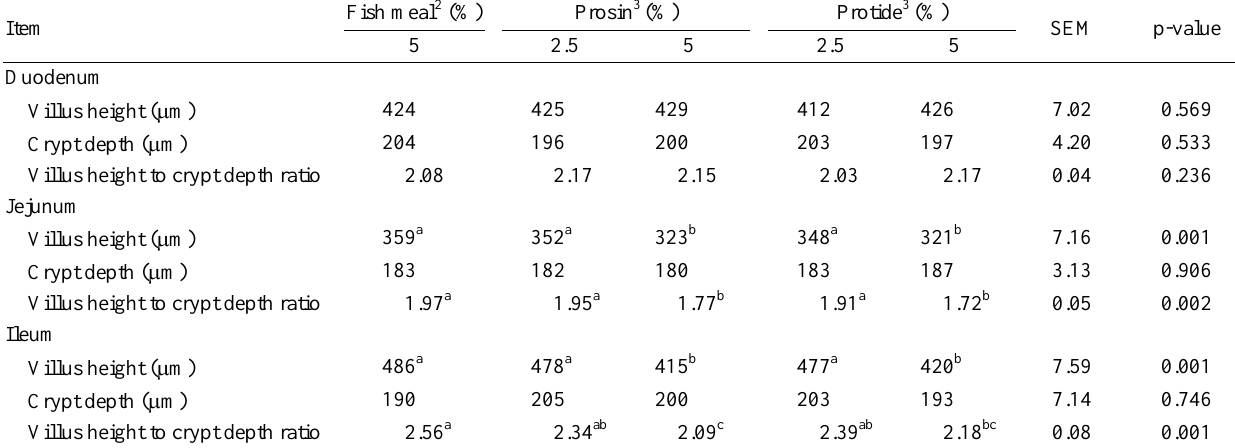
Table 9. Effects of single-cell proteins (Prosin and Protide) replacing fish meal in diet on intestinal morphology of weaned piglets, Exp. 3